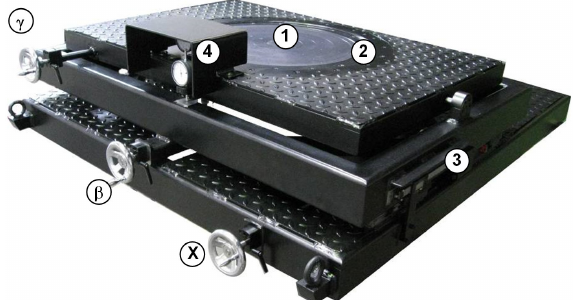
Figure 3: General purpose adapter available for sensor mounting. 1 (cid:13) Opening for sensor baffle (cov- ered); 2 (cid:13) Flanges of different size to mount sensor; 3 (cid:13) Sliding rule to read the X setting; 4 (cid:13) Meters to read the settings of β and γ ; X (cid:13) , , : Hand wheels to align the indicated β (cid:13) γ (cid:13)